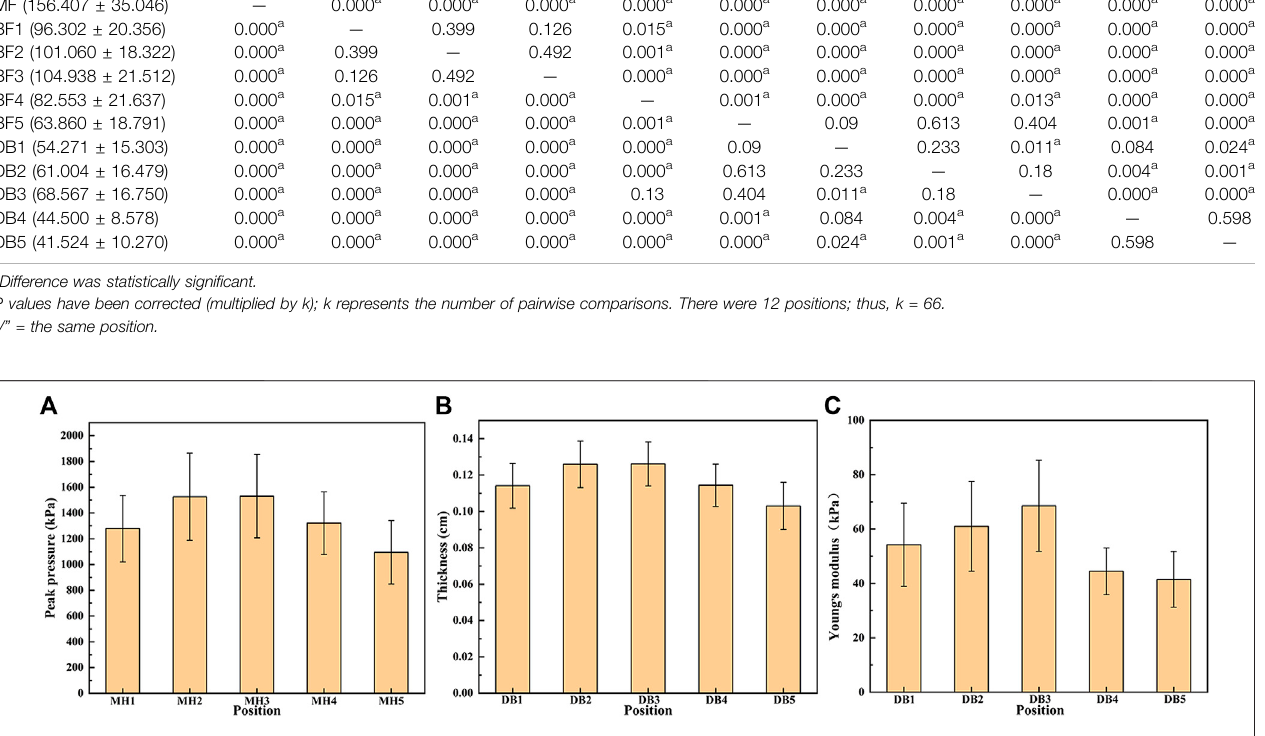
FIGURE4| Thepeakpressureunderthe fi vemetatarsalheads(MH1 – MH5) (A) ,thethickness (B), andYoung ’ smodulus (C) inthe fi vedistalbranchesoftheplantar fascia in 15 fl atfeet.